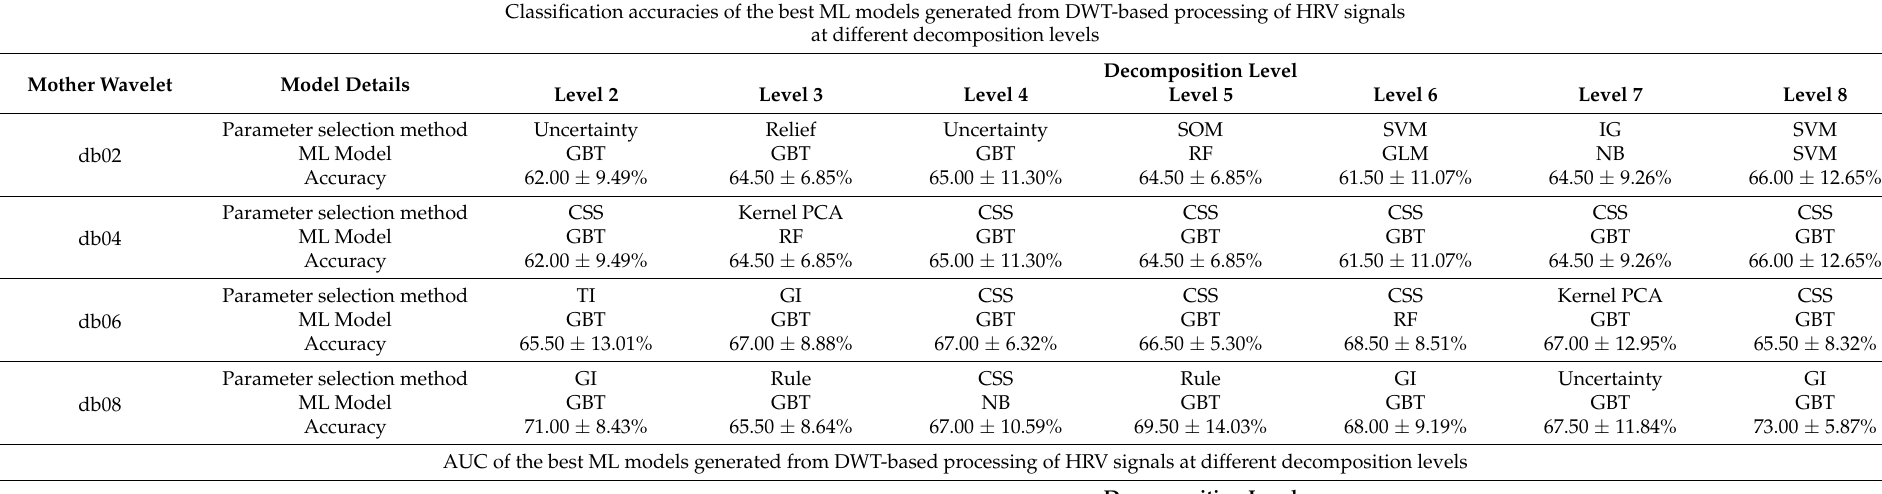
Table 4. Classification and AUC accuracies of the best ML models generated from DWT-based processing of HRV signals at different decomposition levels.